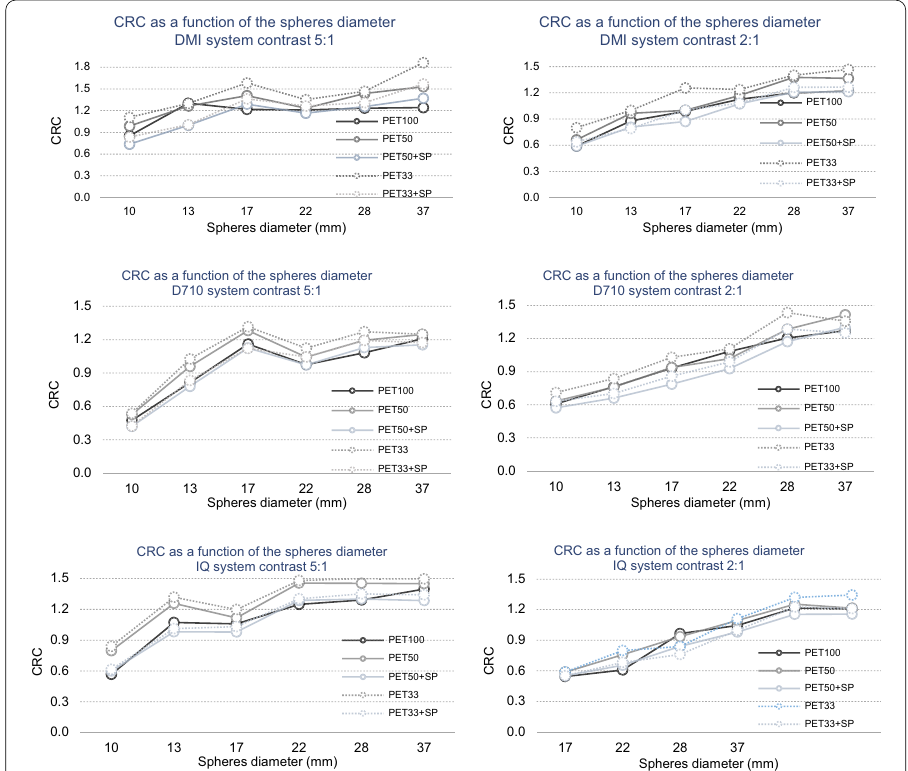
Fig. 5 Contrast Recovery (CRC measured image contrast/theoritical contrast) as a function of sphere = diameter, acquisition time (PET100, PET50 and PET33) and SubtlePET application (PET50 for the 3 PET systems (1st row: DMI; 2nd row: D710 and 3rd row: IQ4) and 2 contrasts (1st column:5:1 and 2nd colomn:2:1)